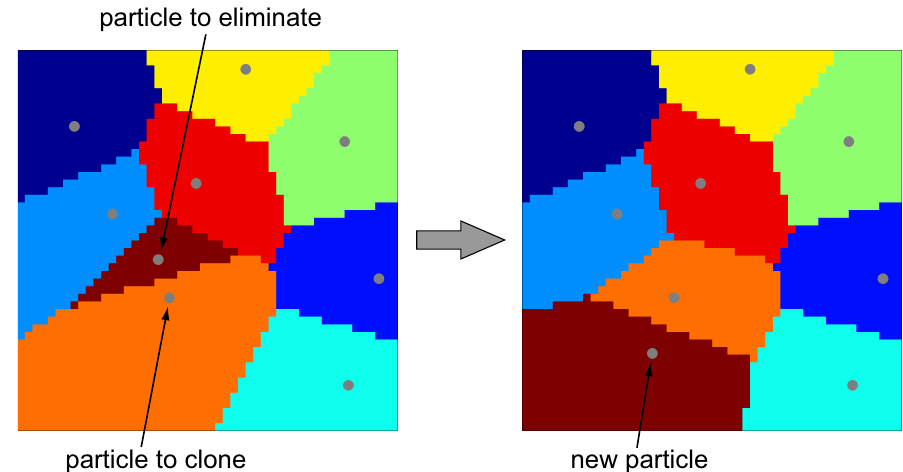
Figure 4. Elimination and cloning of Lagrangian